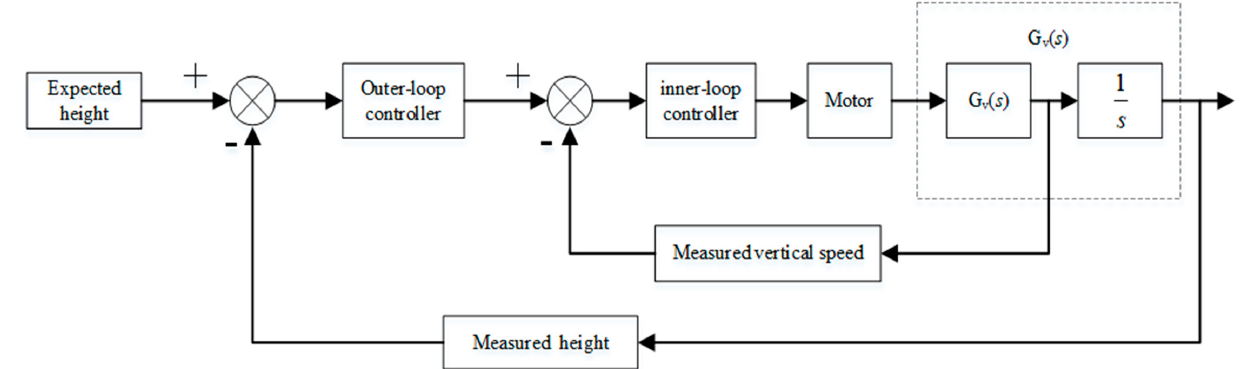
Figure 6. Structure of the cascade PID for the height and velocity control.